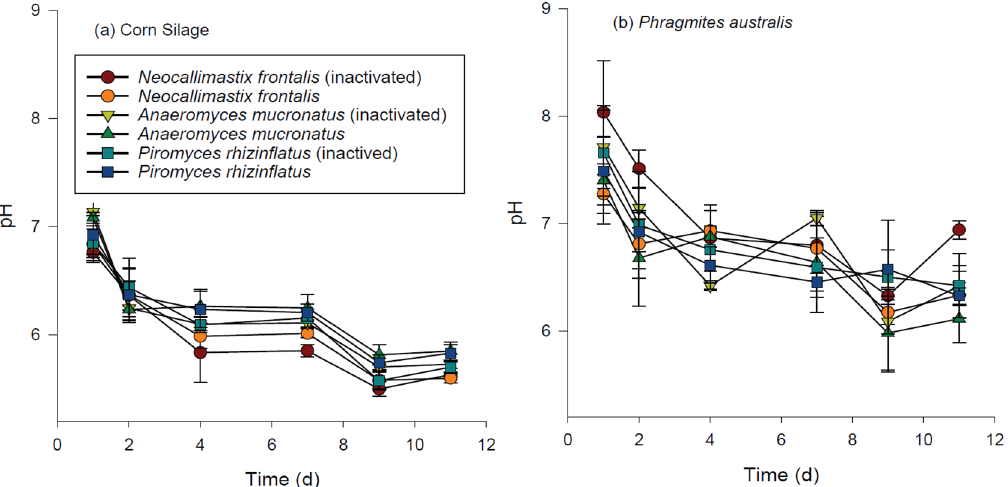
Figure 5. Changes in pH in the bioaugmentation of three different anaerobic fungal species with and without activation: ( a ) corn silage ( Zea mays L.); ( b ) common reed ( Phragmites australis ). Error bars show standard deviation.